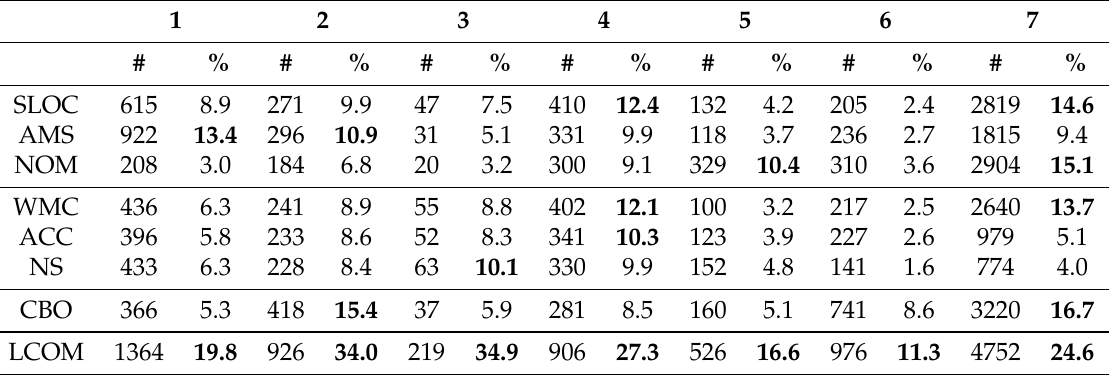
Table 3. Number of potentially deficient classes within Alfresco Repository (1); JasperReports Library (2); JHotDraw (3); ApacheTomcat (4); Jenkins (5); Gradle (6) and Liferay Portal (7) identified by using each software metric separately.